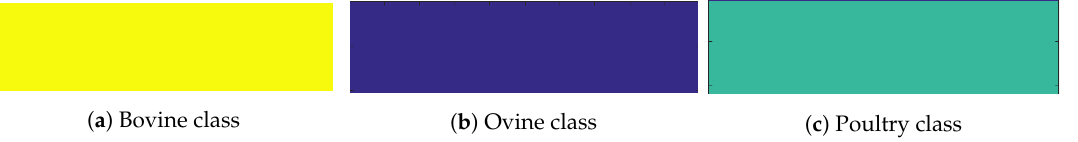
Figure 9. Ground truth representations for classification of minced meat types. ( a ) Bovine class; ( b ) Ovine class; and ( c ) Poultry class.